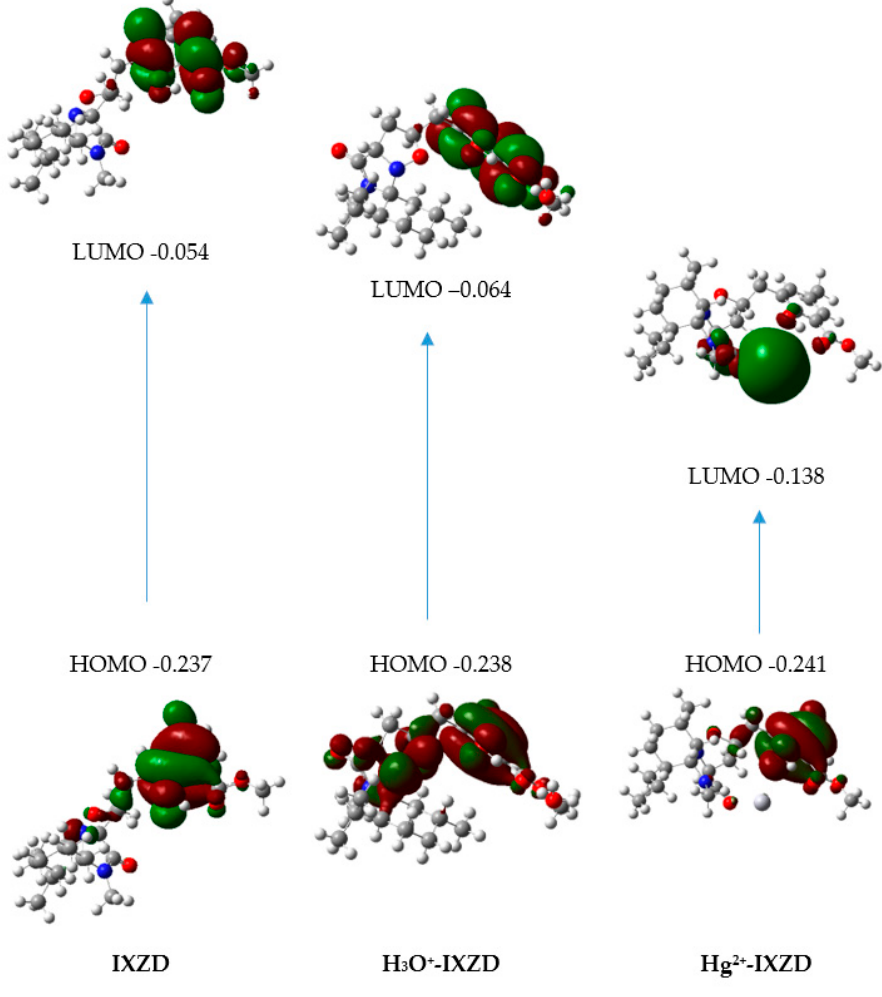
Figure 10. Frontier orbitals and their energies for L, H 3 O + ‐ IXZD, and Hg 2+ ‐ IXZD. Table 3. TDDFT data of selected electronic transitions, absorption energies, and oscillator strengths.